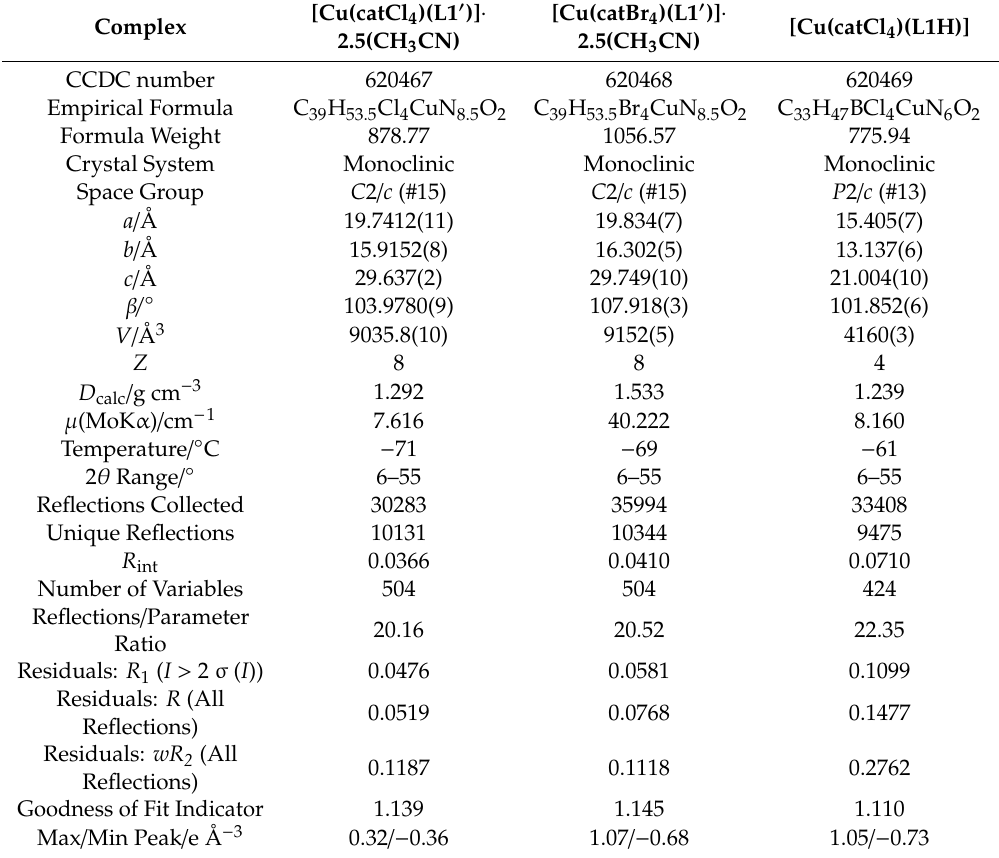
Table 2. Crystal data and structure refinement of copper